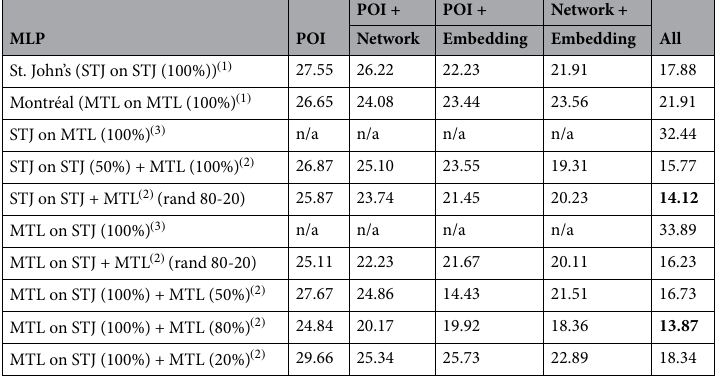
Table 4. Exploration of the three experimentation approaches (1) matching, (2) combined and (3) zero-user- input over 5 different feature combinations and 2 different data split approaches based on data from the cities of St. John’s NL and Montréal QC reflecting MAE error range of 0–100 units. Significant values are in [bold].